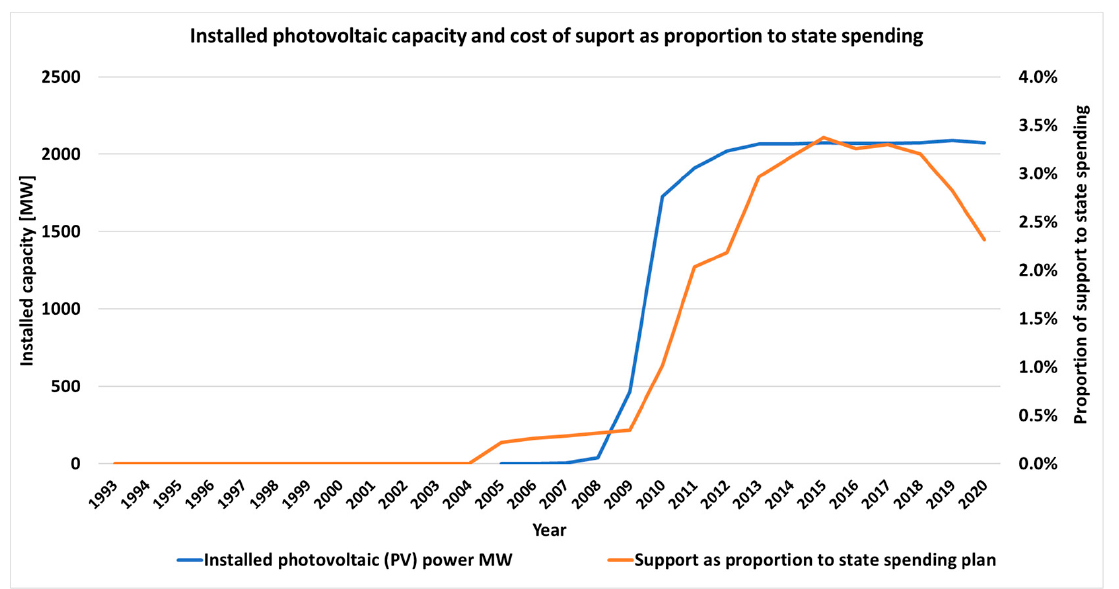
Figure 11. Installed photovoltaic capacity.